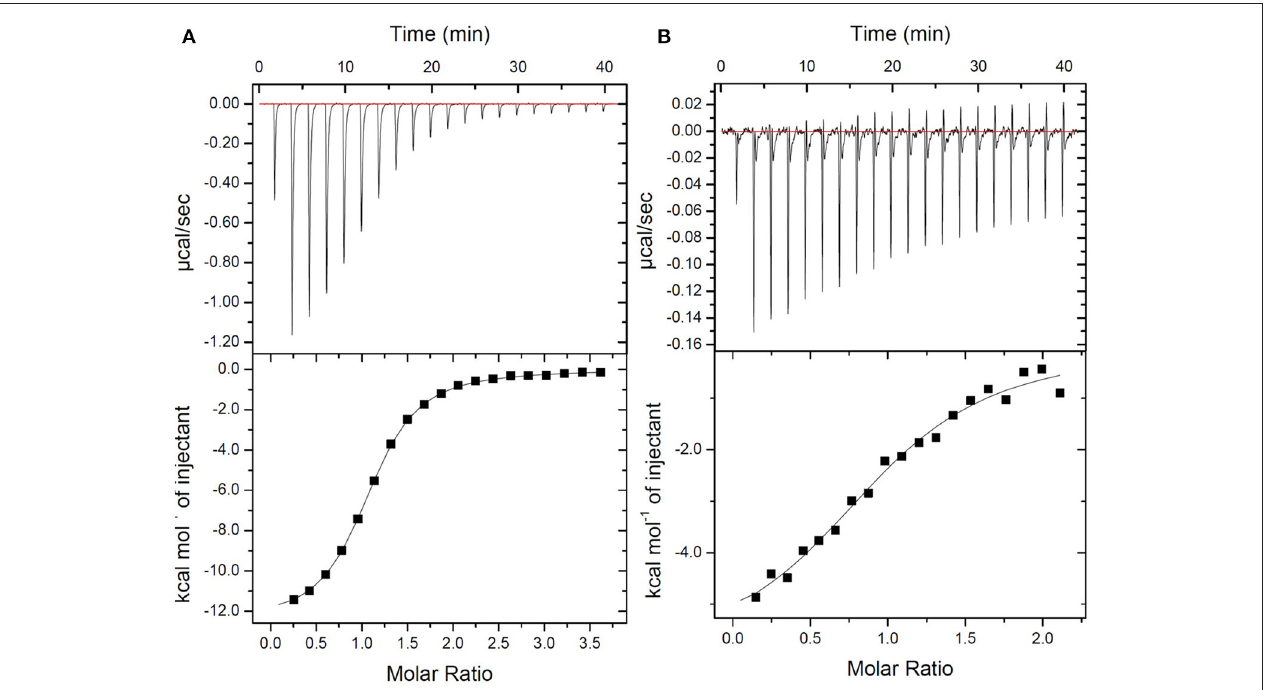
FIGURE 2 | Thermodynamic evaluation of Ac-L-Lys-D-Ala-D-Ala-OH binding to DLF-1. Top: Raw curve of power vs. time. Bottom: Fit of integrated peak areas (heat released per injection) used to determine the thermodynamic parameters presented in Supplementary Table 1. (A) Representative ITC data measuring the thermodynamics of binding of peptide to Vancomycin. Peptide (600 µ M) was titrated into a solution containing vancomycin (32 µ M) in 1X PBS at 25 ◦ C. (B) Representative ITC data measuring the thermodynamics of binding of peptide to DLF-1. One percent of DMSO was added to control and test titrations, as it increased solubility of